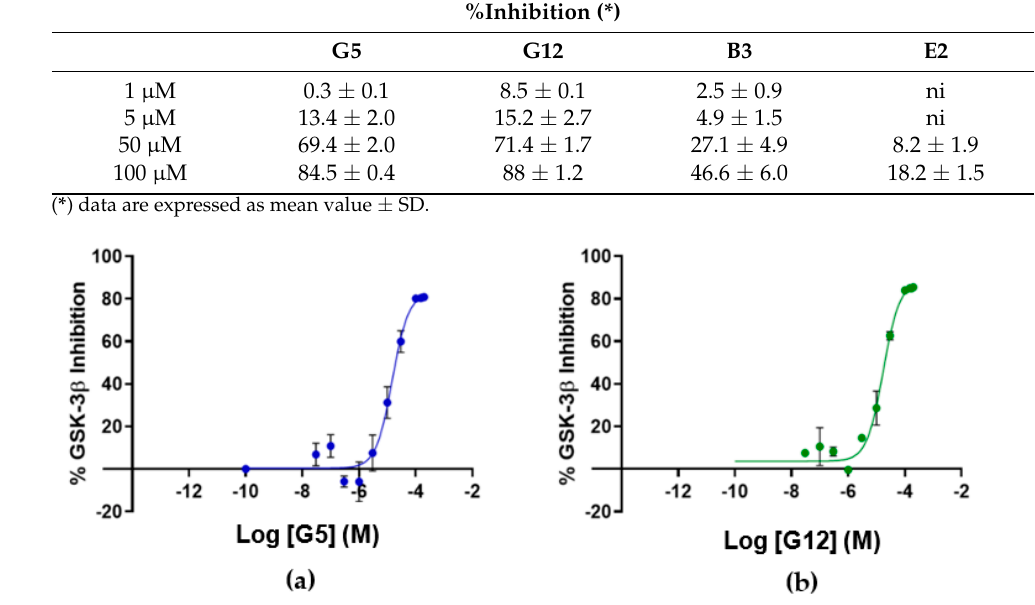
Figure 5 . Dose − response curves for GSK-3 β inhibition by G5 ( a ) and G12 ( b ). Error bars denote SD. To have insights into the mechanism of GSK-3 β inhibition, G5 and G12 were tested for their ability to competitively replace ATP or the GSK-3 β substrate ULight-GS (Ser641/pSer657), as described in the Section